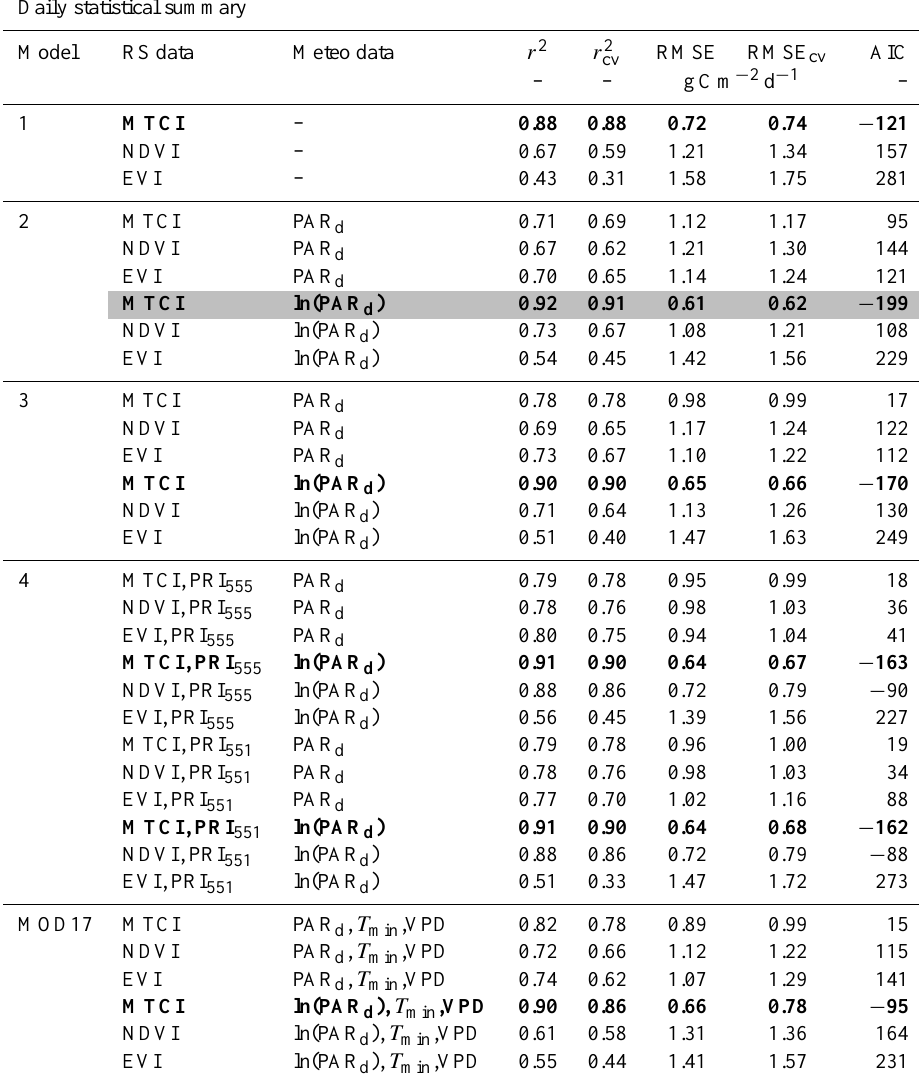
Table 4. Summary of statistics in fitting ( r 2 and RMSE) and cross-validation ( r 2 cv , RMSE cv and AIC) of different models tested in this study using GPP d and PAR d data. The best-performing models in each class are in bold print. The most successful of all models is grey